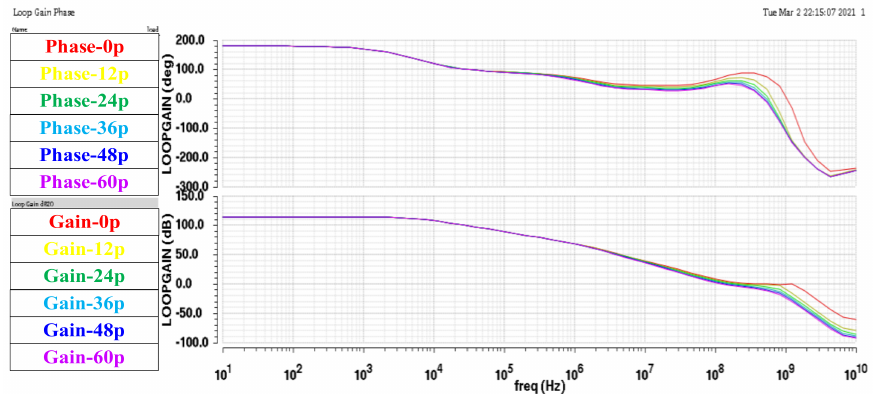
Figure 10. The simulated bode diagrams of the DLAFC configuration under different capacitor load between 0–60 pF.